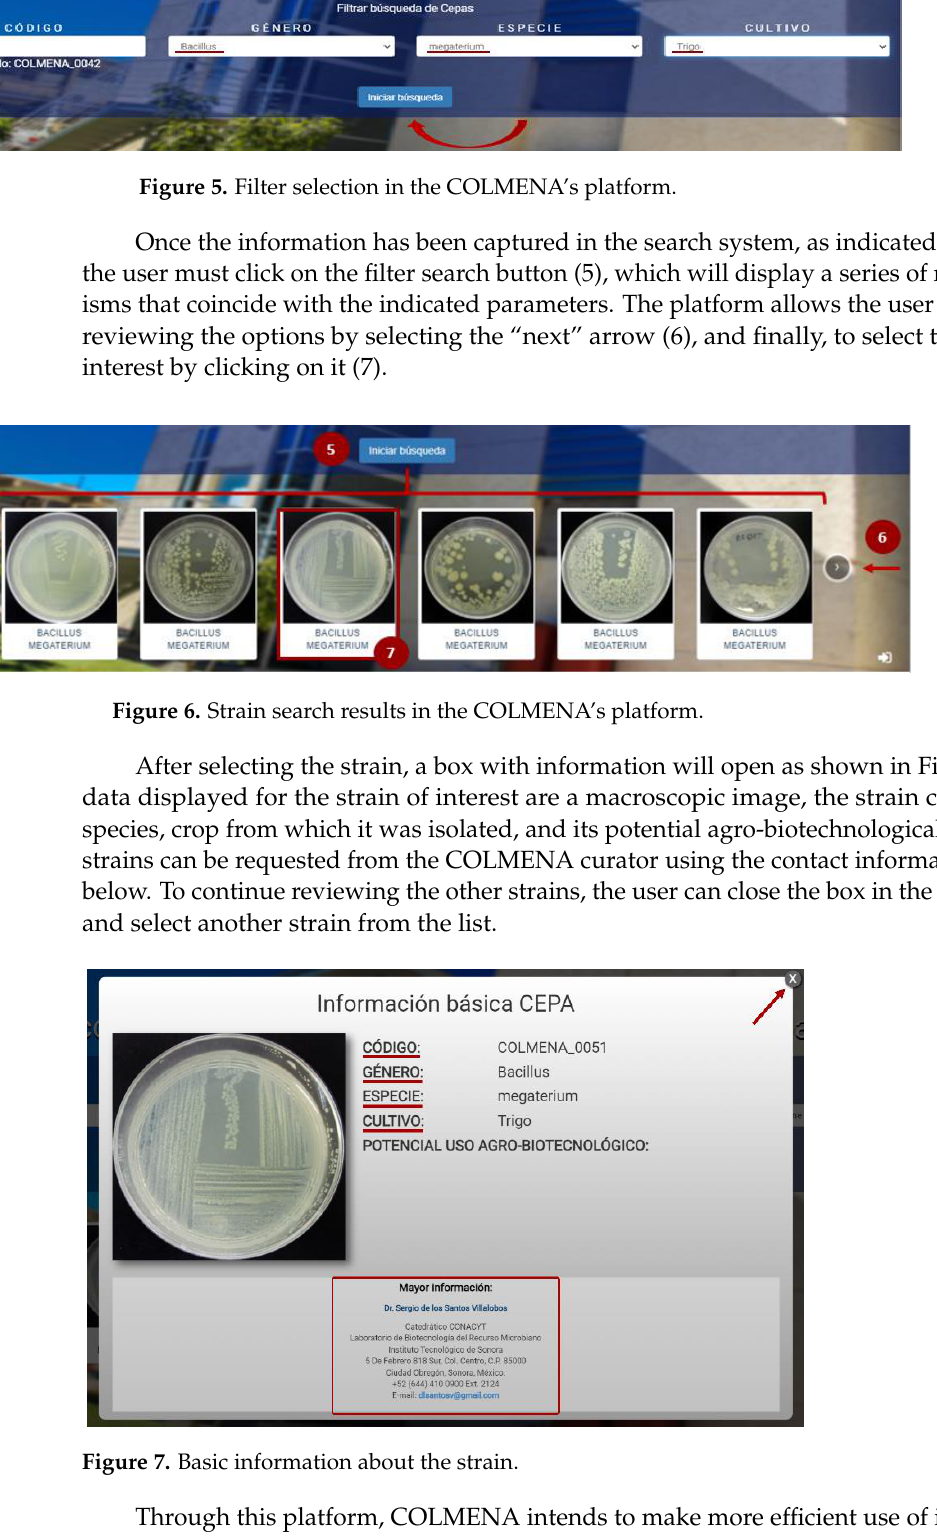
Figure 4. COLMENA’s platform categorization system (http://apps2.itson.edu.mx/colmena, ac- cessed on 21 July 2021).